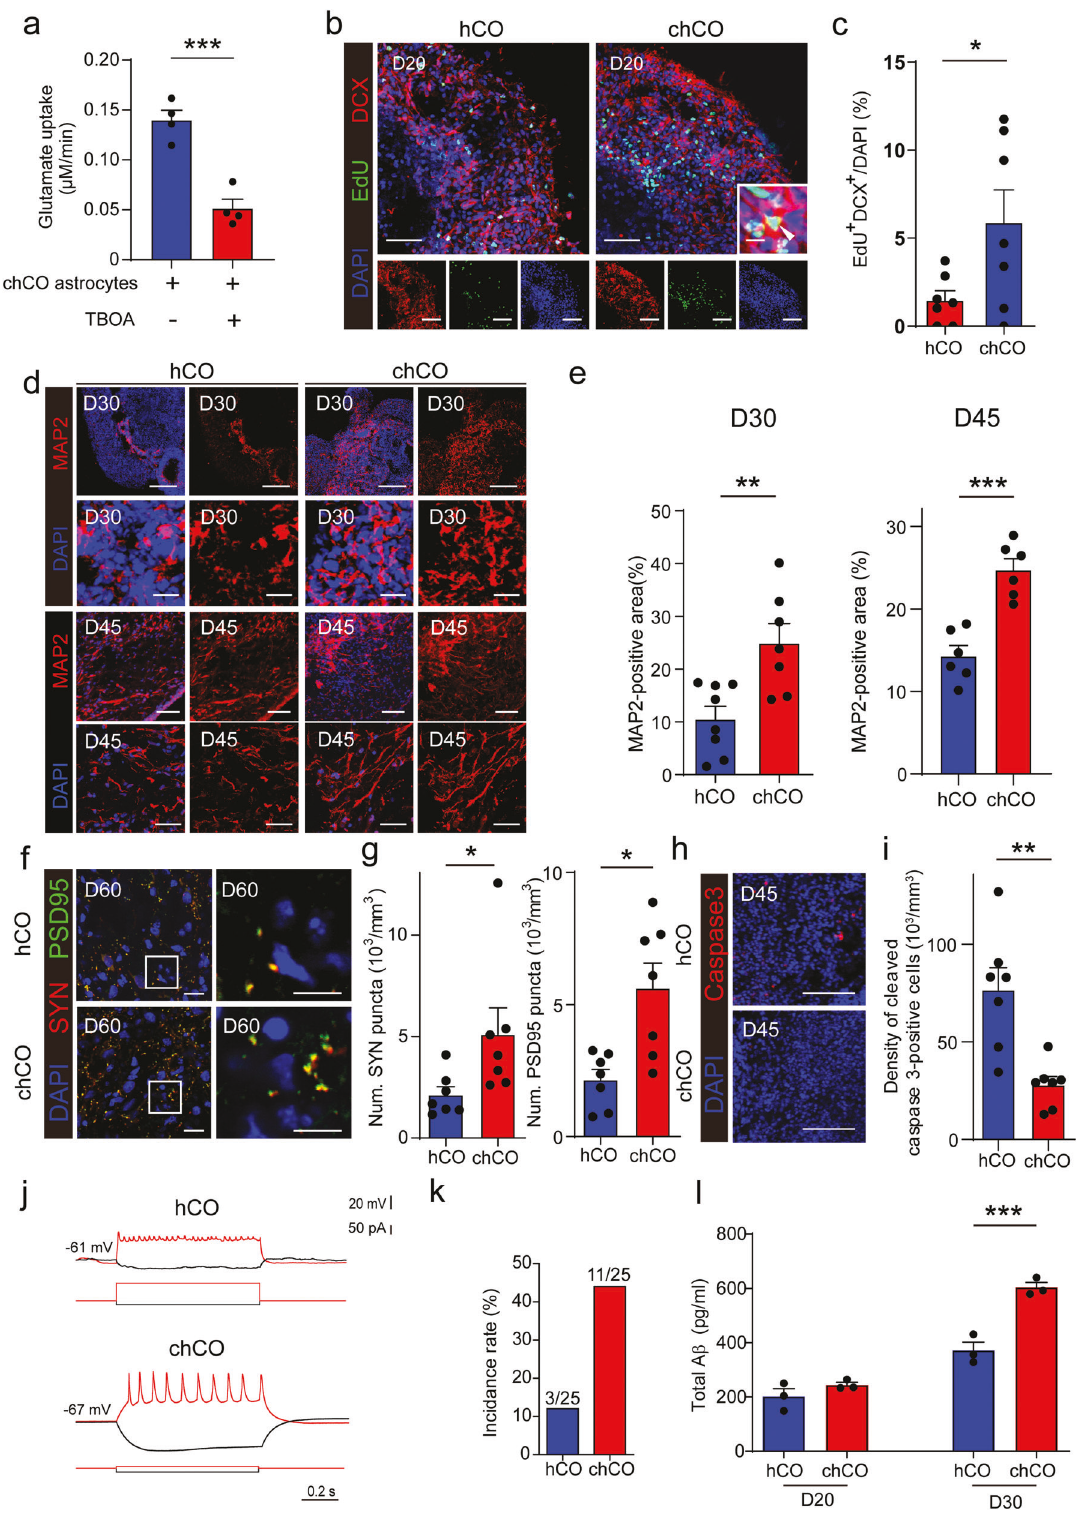
Moreover, with these chimeric organoids, we are able to assess the intricate and cell type-dependent effects of various disease risk genes in a more physiologically relevant context. APOE4 has a profound impact on dysregulation of lipid metabolism associated with AD pathogenesis. We observed